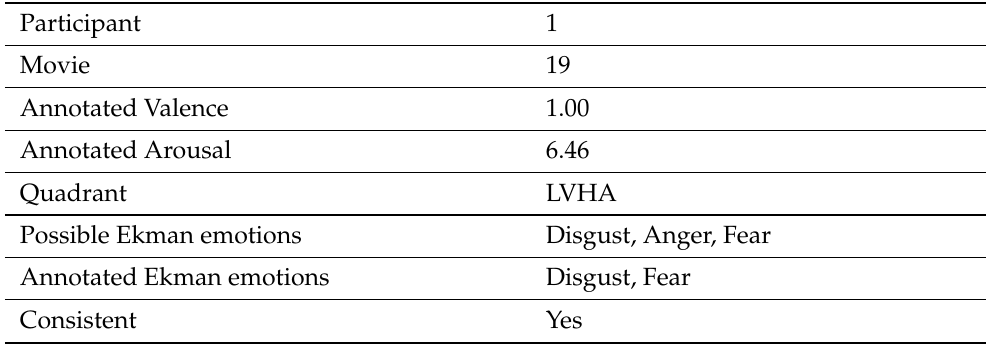
Table 7. Example showing the method of determining internal consistency of